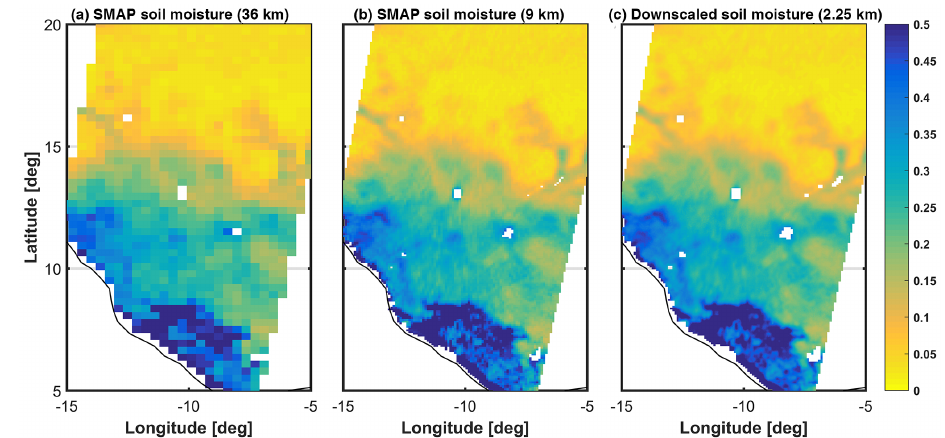
Figure 6. Example of a snapshot of soil moisture estimates from SMAP at 36km (a) and 9km (b) , and the downscaled estimates at 2.25km (c) in western